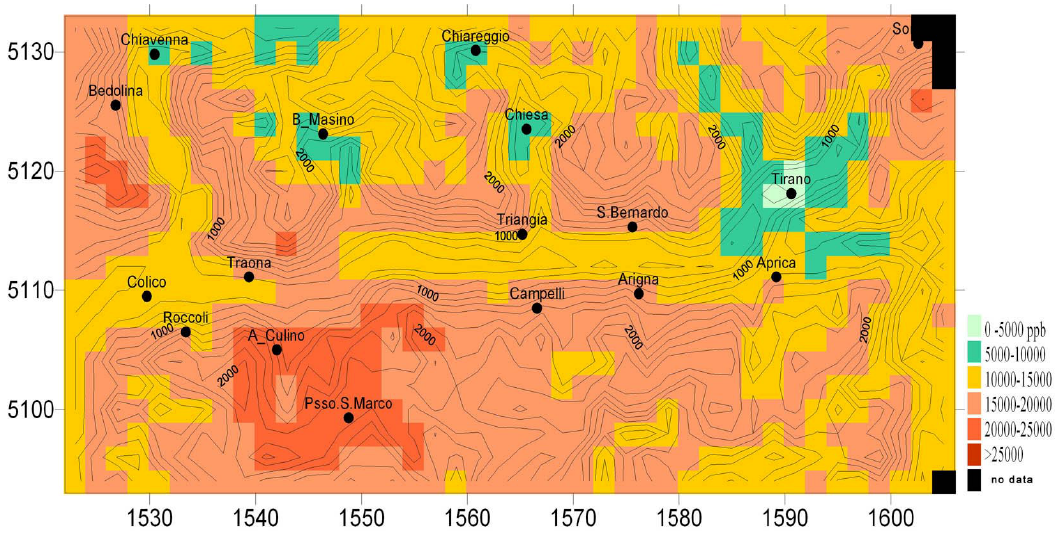
FIGURE 7. AOT40 distribution into the domain (corrected concentration data).